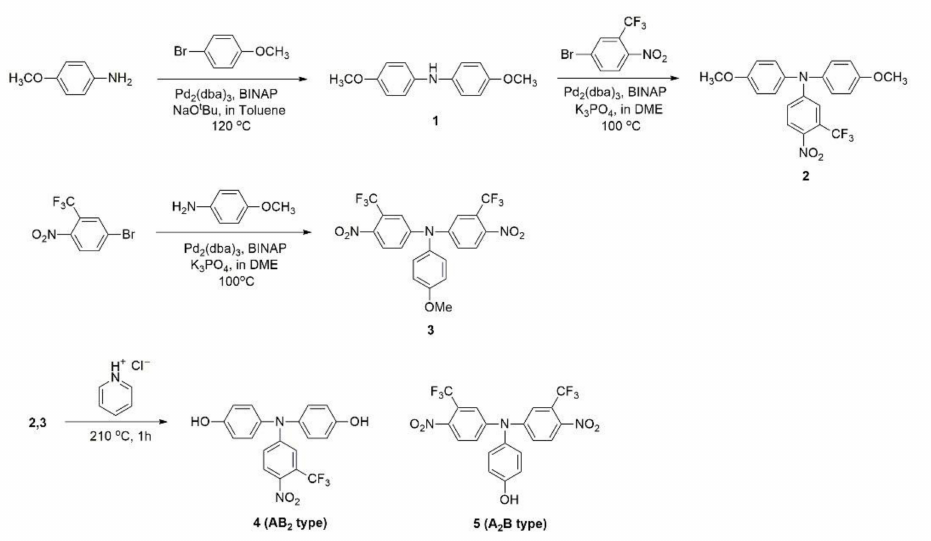
Figure 1. During the reaction, the phenoxide groups attack the ipso carbon of the aromatic rings. Then the nitro-leaving groups that are activated with the trifluoromethyl groups are substituted to form the ether bonds, which results in hyperbranched poly(triphenylamine)s. Scheme 1 summarizes our synthetic route to the monomers. p -Anisidine and 4-bromoanisole underwent a palladium-catalyzed amination reaction to form a dipheny- lamine compound 1. The intermediate 1 was coupled with 5-bromo-2-nitrobenzotrifluoride, which produced a triphenylamine compound 2 with a methoxy-protected hydroxyl group. When the methoxy groups in 2 were deprotected with pyridine hydrochloride, an AB 2 type monomer 4 was obtained. Meanwhile, coupling the 5-bromo-2-nitrobenzotrifluoride with p -anisidine afforded a methoxy-protected triphenylamine 3, and the same deprotec- tion process gave an A 2 B type monomer 5. The chemical structure of the monomers was confirmed by 1 H and 13 C NMR, as shown in Figures